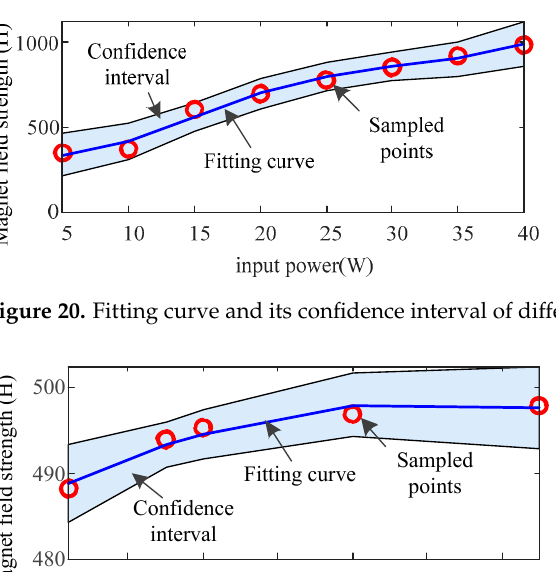
Figure 19. Fitting curve and its confidence interval of different radius.